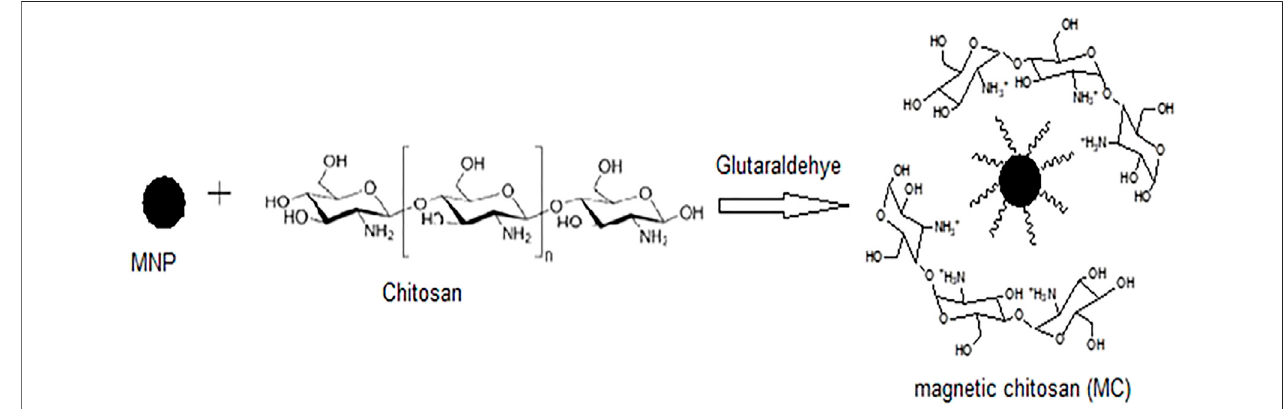
FIGURE 1 | Proposed route for the synthesis of MC particles.